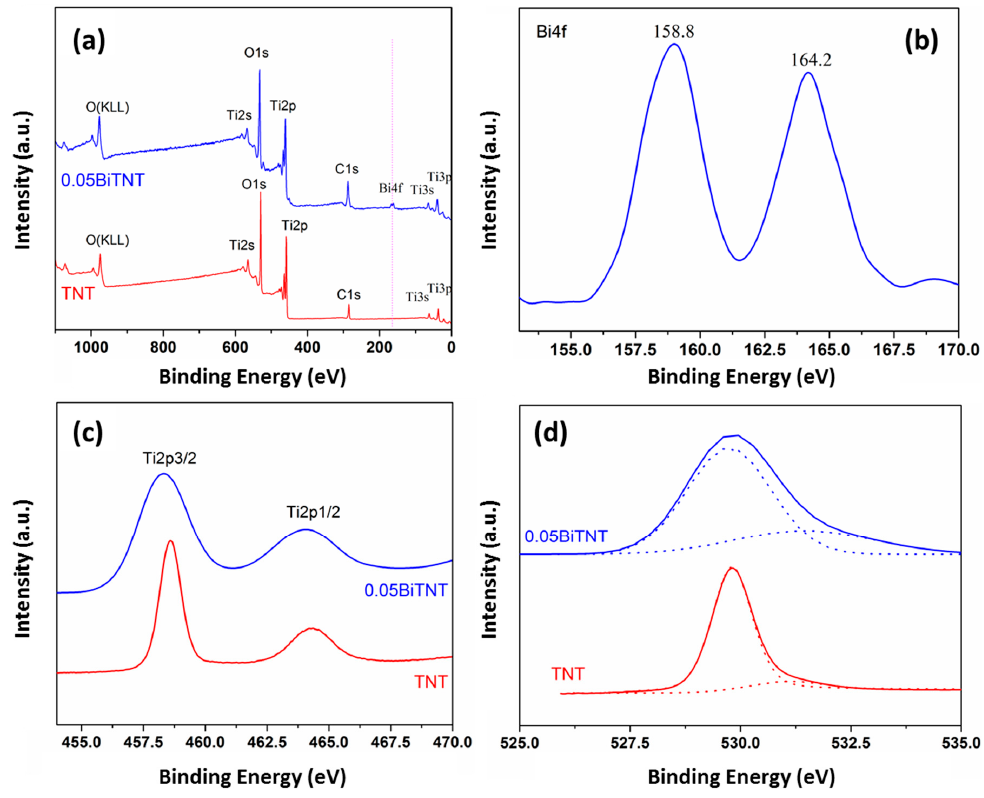
Figure 7. XPS studies of TNT and 0.05BiTNT; full XPS spectra ( a ); and high-resolution XPS spectra of Bi 4f ( b ); Ti 2p ( c ); and O 1s ( d ) regions.